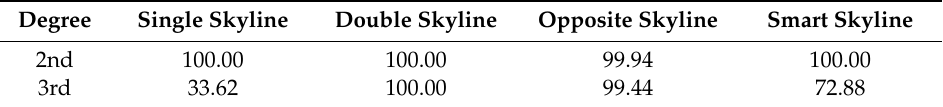
Table 16. Polynomial curve-fitting on the synthetic Dataset II.